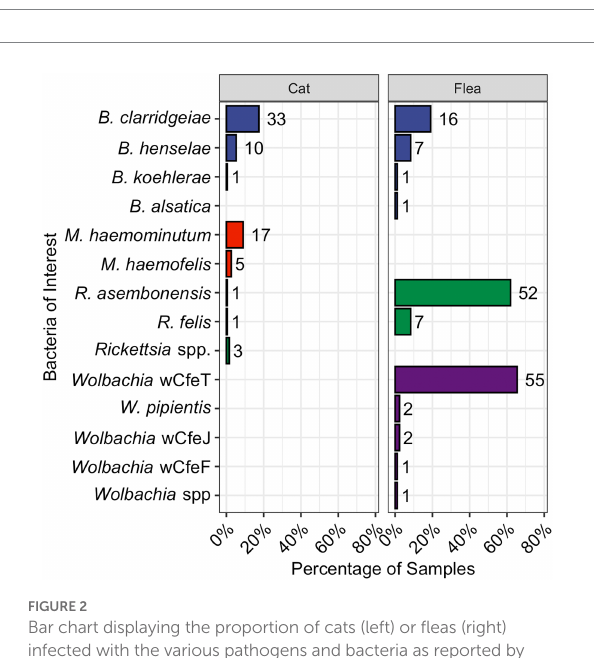
FIGURE 2 Bar chart displaying the proportion of cats (left) or fleas (right) infected with the various pathogens and bacteria as reported by qPCR. The total number is displayed to the right of each bar. Bartonella spp., are in blue, hemotropic Mycoplasma spp., in red, Rickettsia spp., in green, and Wolbachia spp., in